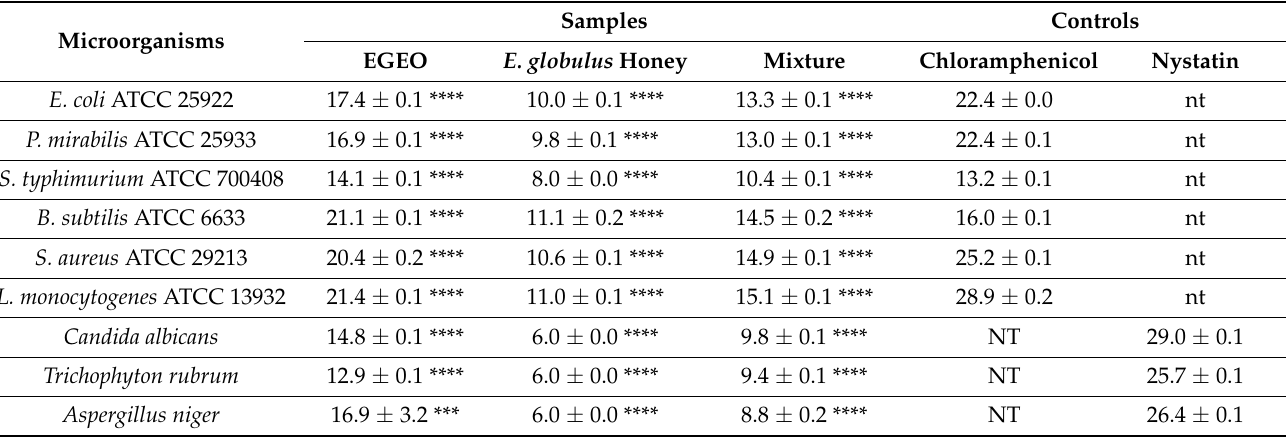
Table 6. Mean zones of inhibition of E. globulus EO, E. globulus honey, and mixture (mean of three replicates ± standard deviations).